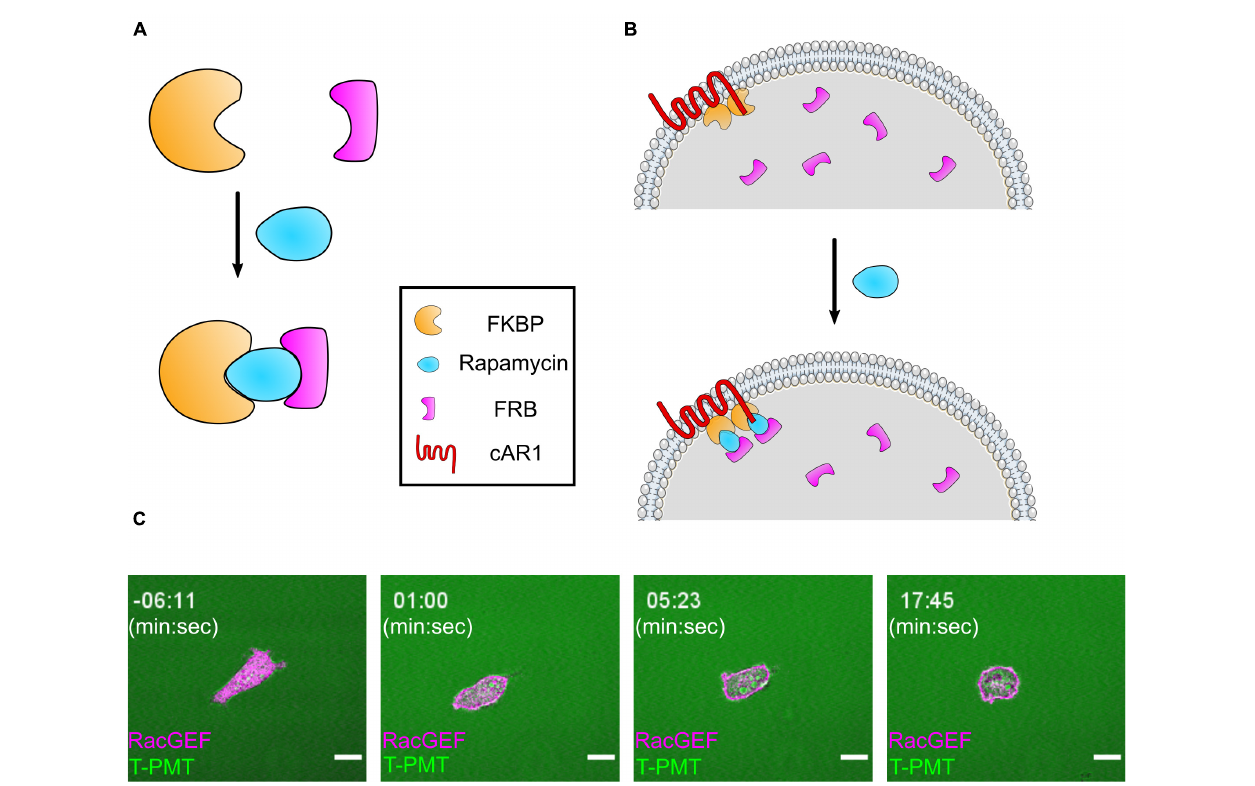
FIGURE 4 | The FKBP/FRB system and its application in cells. (A) Diagram of FKBP/FRB system. FKBP and FRB form a heterodimer in the presence of rapamycin. (B) Illustration of an experimental setup for recruiting a protein to the membrane with the FKBP/FRB system in Dictyostelium . 2 FKBP domains (FX2) are anchored to membrane by cAR1, and the actuator attached to an FRB domain is diffusing in the cytosol. When rapamycin is added, the actuator is recruited to membrane by binding to FKBP. (C) Scanning confocal imaging of an AX3 Dictyostelium cell expressing a CID system designed to increase RacB and Rac1A activity. The cell is expressing cAR1-FKBP-FKBP (unlabeled) and mCherry-FRB-RacGEF1 (cid:49) N , an activator of Rac1 fused to an FRB domain. After rapamycin addition, RacGEF1 (cid:49) N is recruited to the membrane. Consistent with previous reports, the cell became very round with small, short-lived protrusions. Scale bars = 10 µ m. t = 00:00 indicates rapamycin